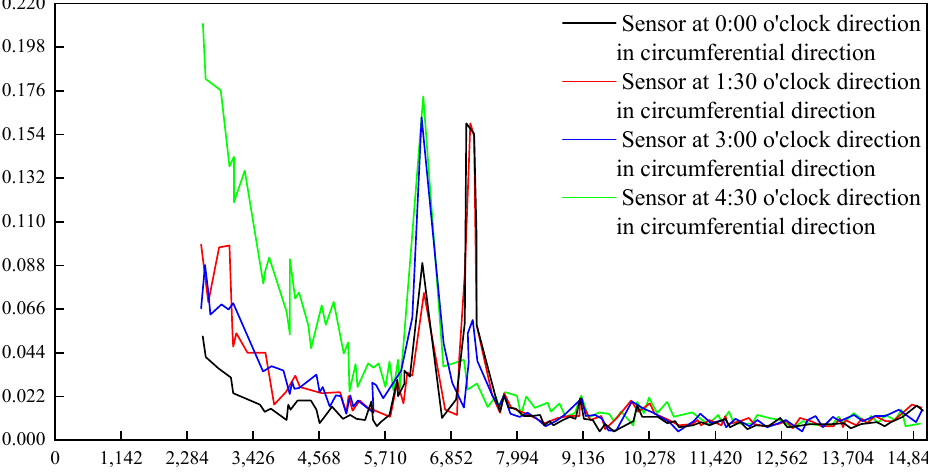
Figure 12. The vibrational acceleration transmission ratio diagram of measuring point on intermediate casing.